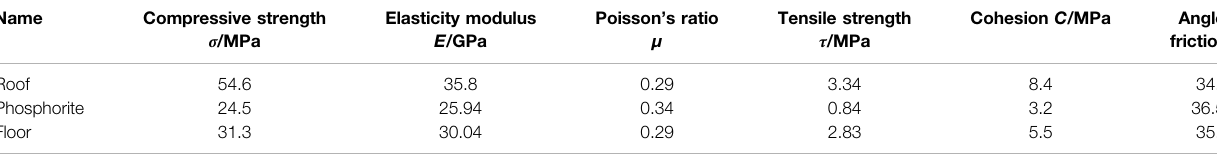
TABLE 1 | Mechanical parameters of strata.